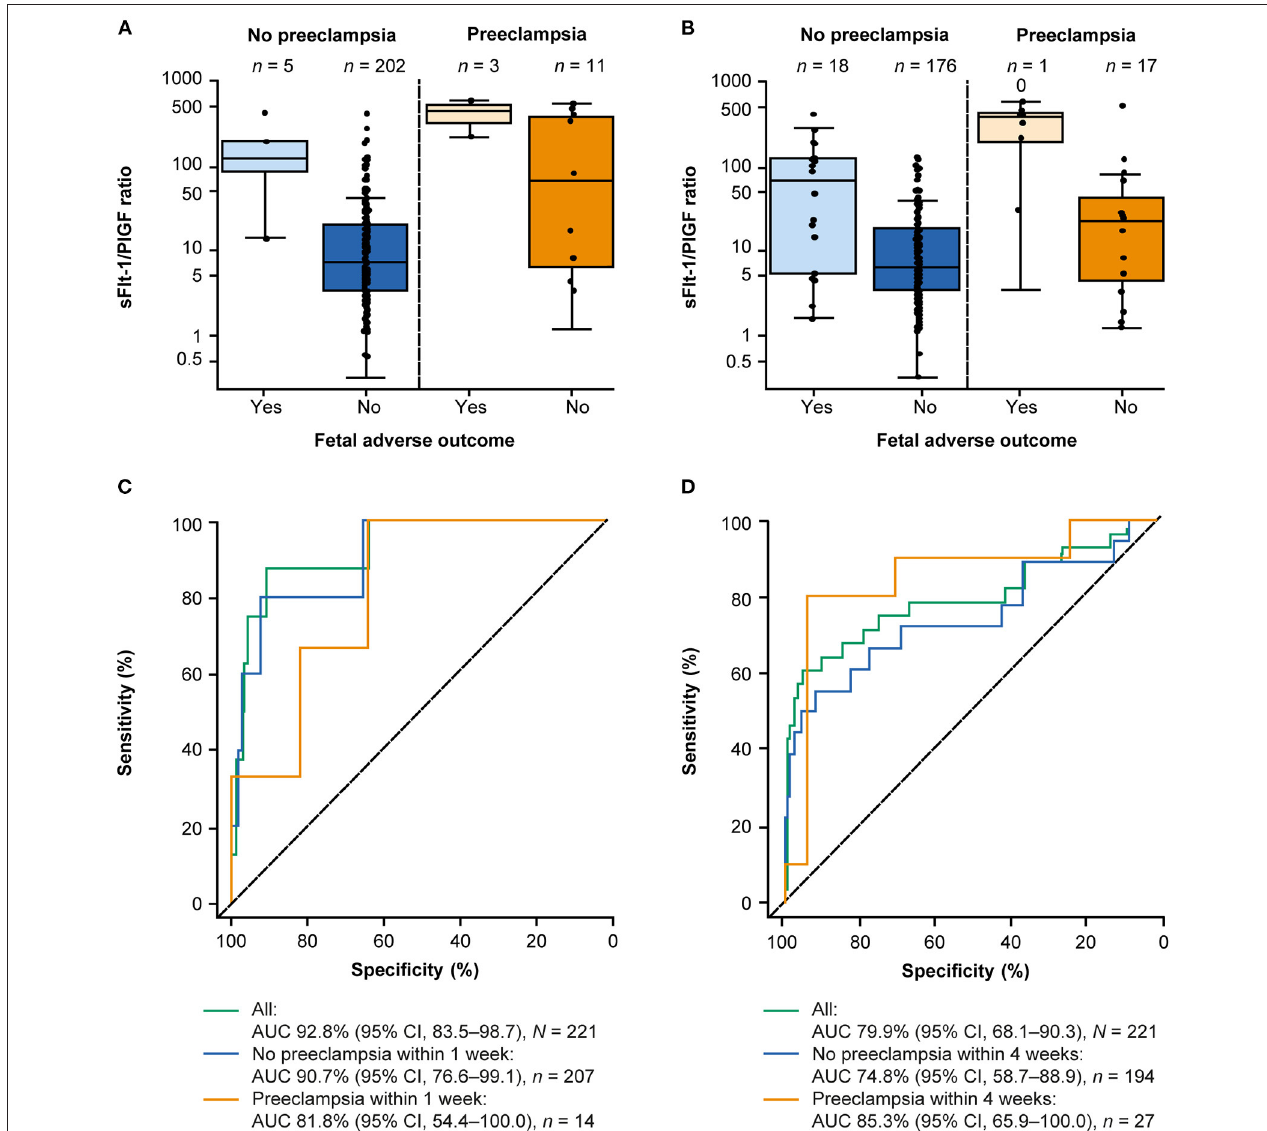
FIGURE 2 | Performance of the sFlt-1/PlGF ratio for predicting FAOs within 1 and 4 weeks. a (A) Distribution of the sFlt-1/PlGF ratio at baseline according to FAO status and preeclampsia status within 1 week and (B) within 4 weeks. b (C) Performance of the sFlt-1/PlGF ratio for short-term prediction of FAOs within 1 week and (D) within 4 weeks. a A total of 221 participants from China were eligible for this analysis. b The boxes represent the first and third quartiles and the median value. The whiskers represent values that are 1.5 × the IQR or shorter in cases where the minimal/maximal value lies within 1.5 × the IQR in log scale. AUC, area under the curve; CI, confidence interval; FAO, fetal adverse outcome; IQR, interquartile range; PlGF, placental growth factor; sFlt-1, soluble fms-like tyrosine kinase